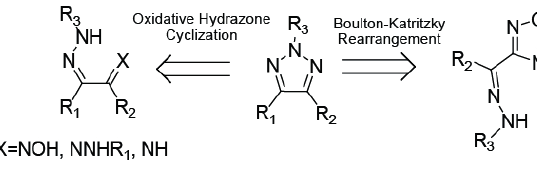
Figure 4 - major approaches toward the - Synthesis of the 1,2,3-triazole skeleton already functionalized in N 2